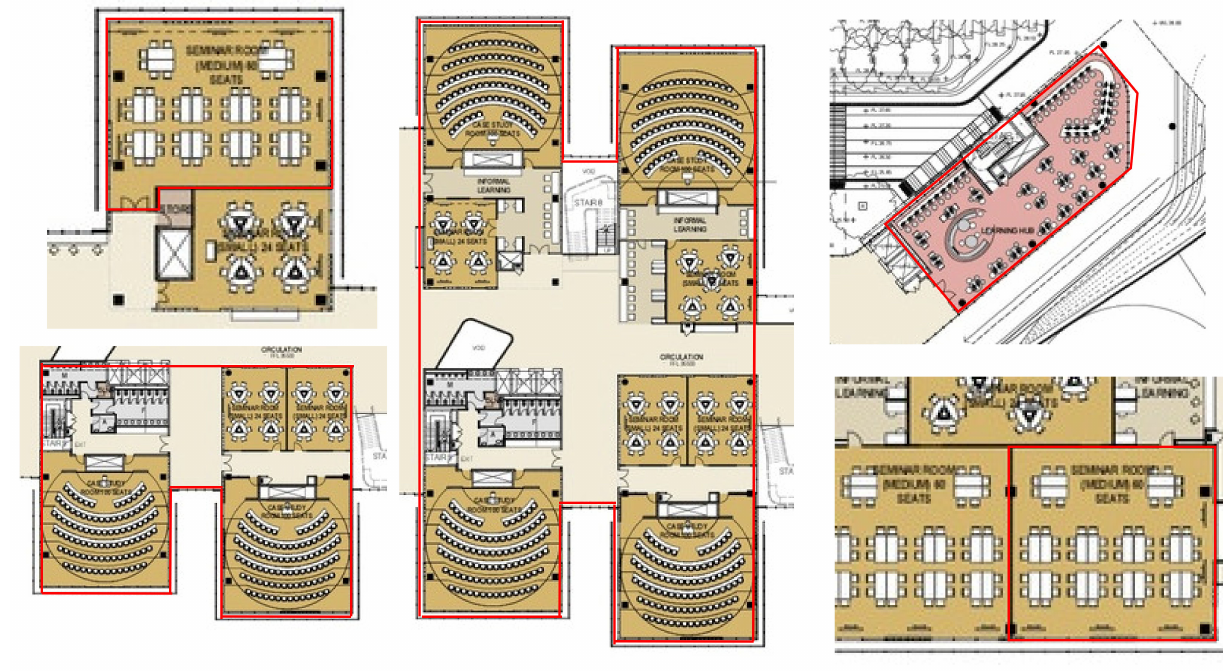
Figure 7. Five shapes (perimeter marked in red) identified in the ABS